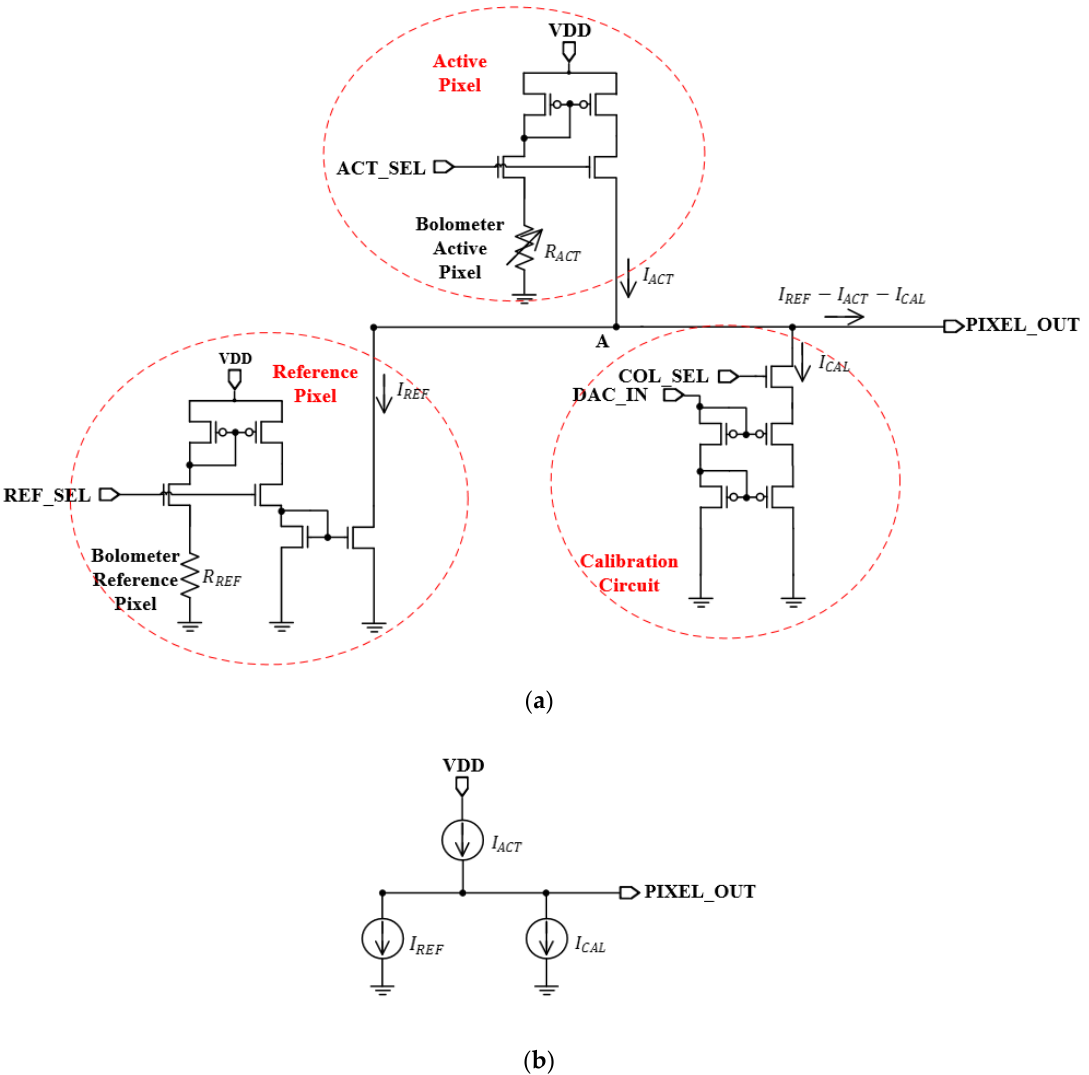
Figure 1. ( a ) Schematic of averaging pixel current adjustment technique ( b ) modeling of averaging pixel current adjustment technique .